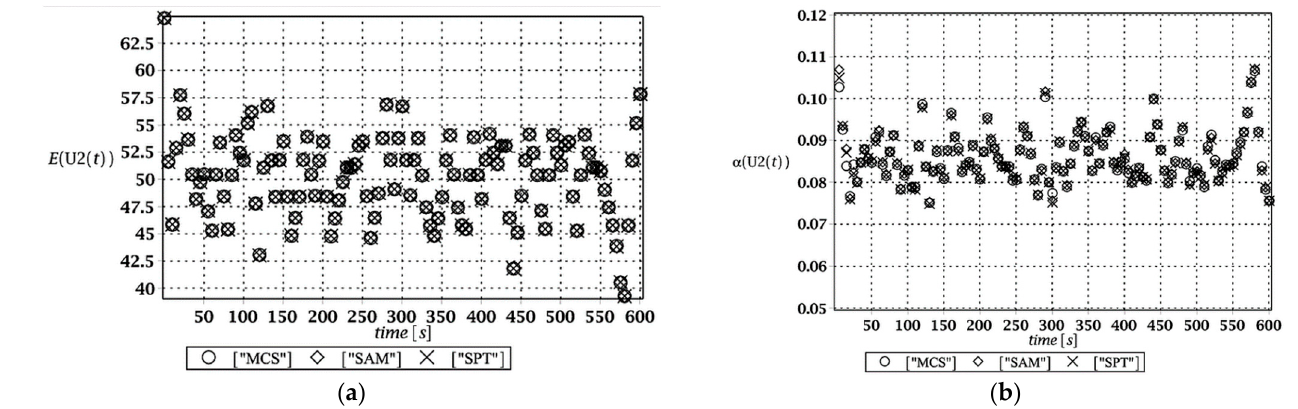
Figure 3. ( a ) The expectation of vertical displacement at the ridge of frame for random level of the snow; ( b ) its coefficient of variation.